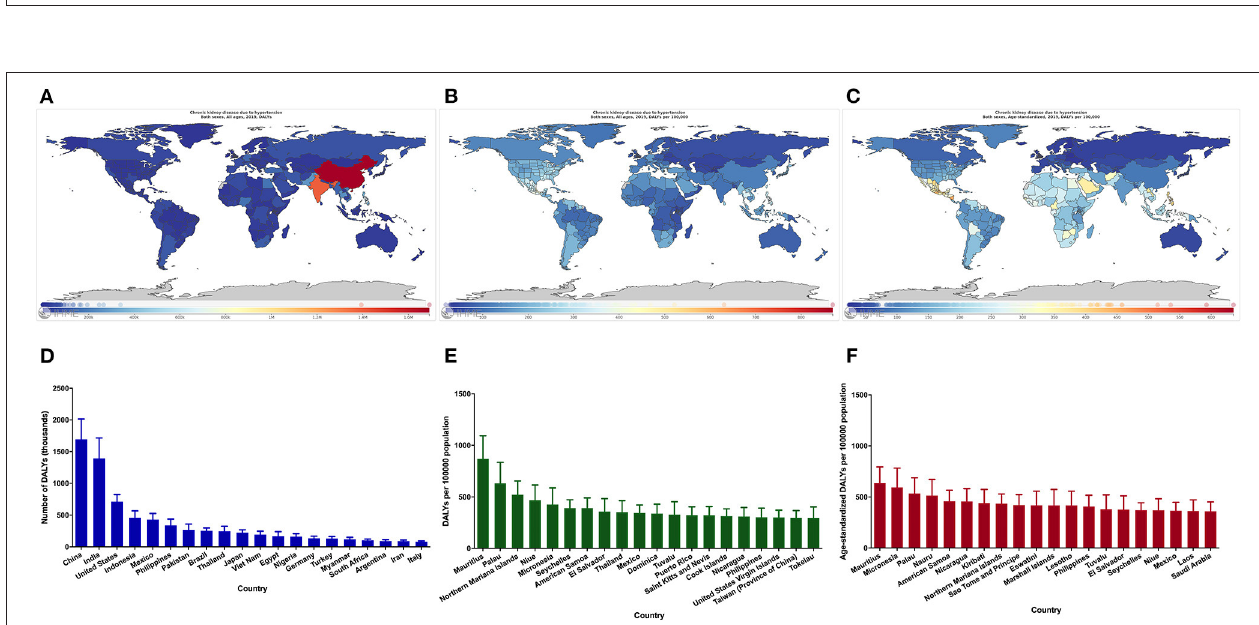
FIGURE 3 | Global map of the disease burden of CKD due to hypertension and the 20 countries with the highest burden. DALY numbers (A) , DALY rates (B) , Age-standardized DALY rates (C) , The 20 countries with the highest DALY numbers (D) , The 20 countries with the highest DALY rates (E) , The 20 countries with the highest age-standardized DALY rates (F) . CKD, chronic kidney disease; DALY, disability-adjusted life-year.